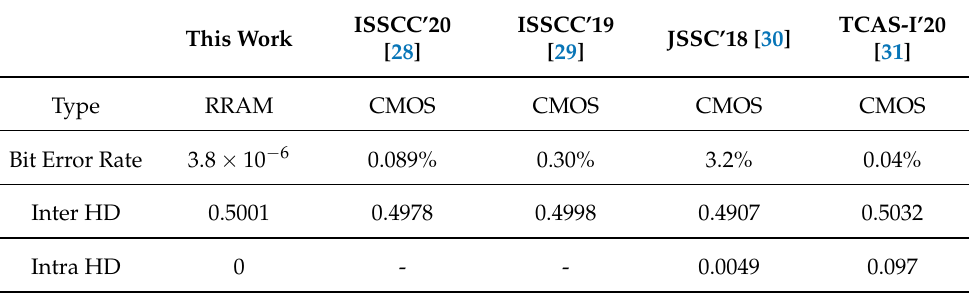
Table 2. Comparison of the RRAM PUF and the previous